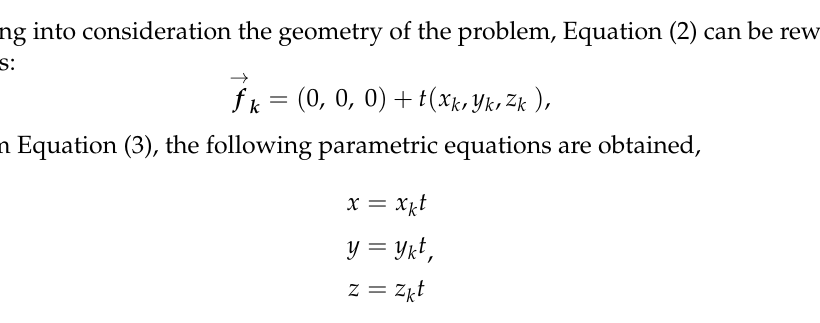
Figure 4. Geometry and collision-free paths generated from object detection and definition of colli- sion − free regions.